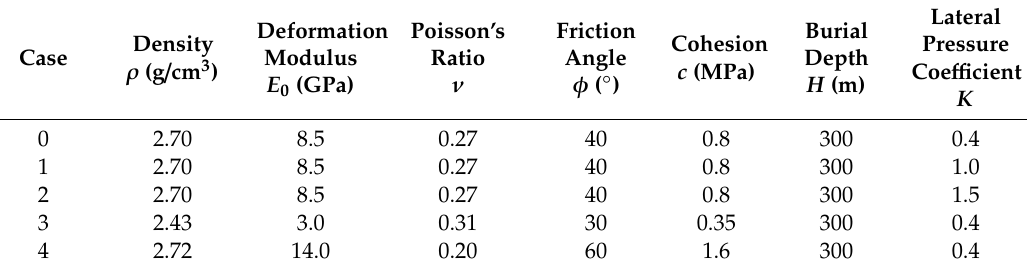
Table 1. Computational parameters of discussions.